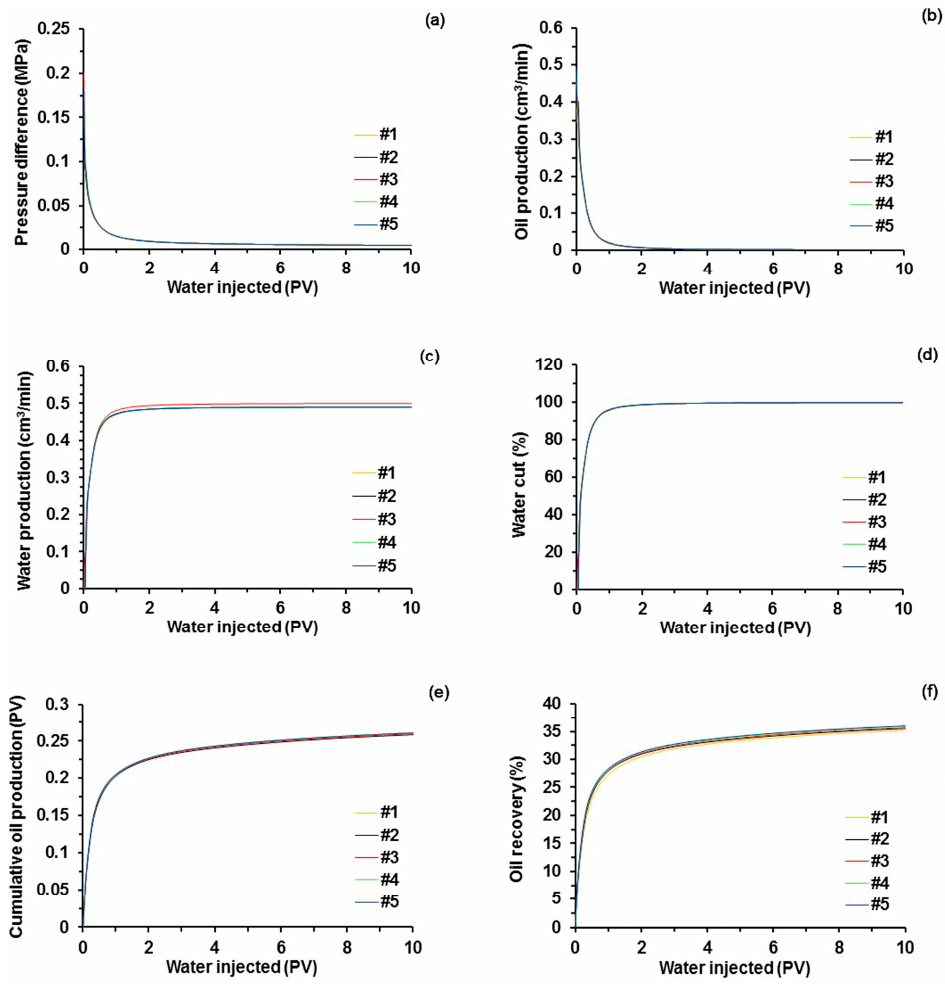
Figure 17. Comparison result of ( a ) pressure difference; ( b ) oil production; ( c ) water production; ( d ) water cut; ( e ) cumulative oil production; and ( f ) oil recovery of the designed simulator in running a same case with different grid sizes, whose model and other parameters were same to those used in simulating the heavy oil displacement experiment.